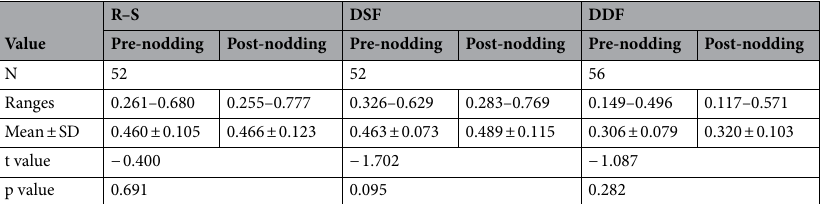
Table 1. Comparison of the temporal parameters obtained before and after the head-nodding period (paired t test). Temporal values were given in milliseconds. The outliers were removed on the base of Box and Whisker Plots analysis.